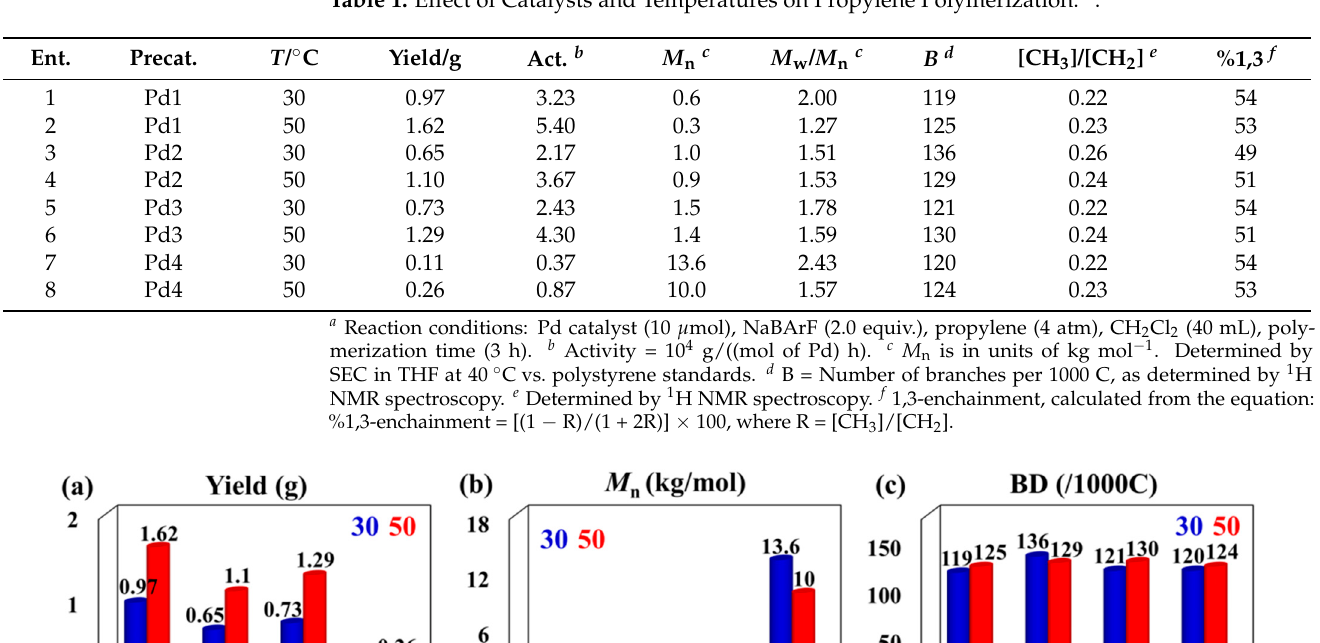
Table 2. Propylene-MA copolymerization. a.